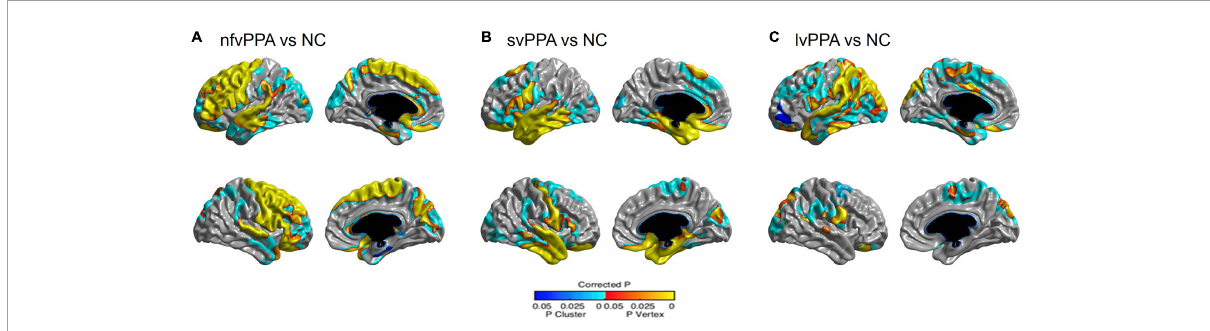
FIGURE1 Statistical representation of cortical thickness in (A) nfvPPA compared to NC, (B) svPPA compared to NC, and (C) lvPPA compared to NC. nfvPPA, non-fluent variant primary progressive aphasia; svPPA, semantic variant primary progressive aphasia; lvPPA, logopenic variant primary progressive aphasia; NC, normal